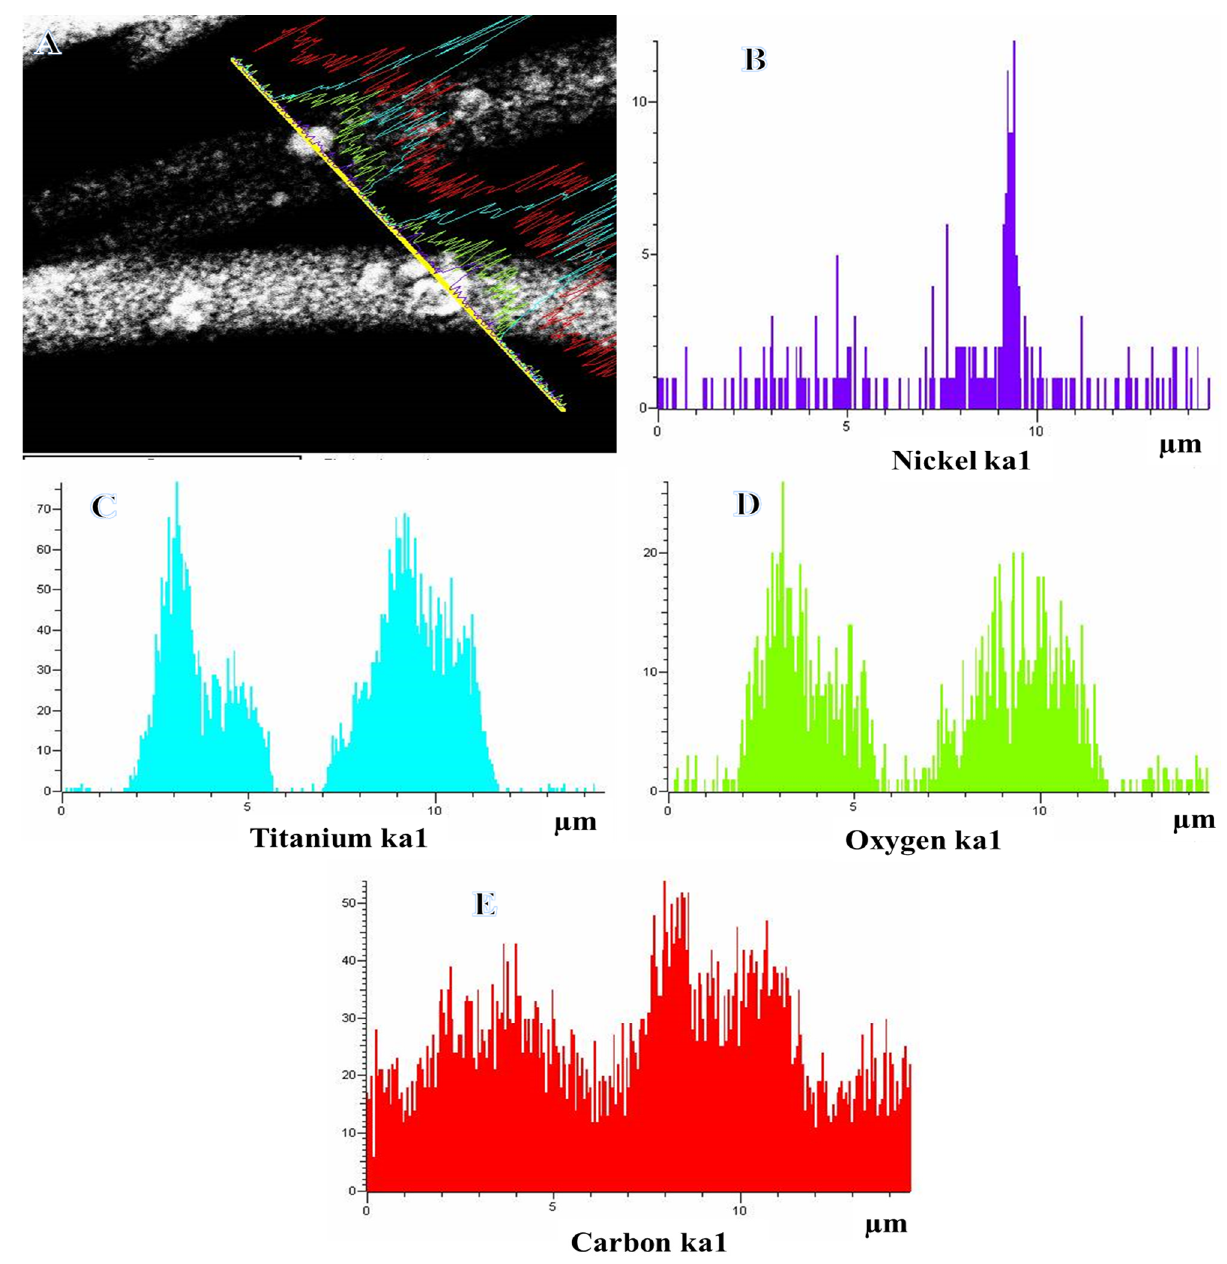
Figure 3. TEM image for a single calcined nanofiber along with the line TEM EDX analysis ( A ) and the corresponding Ti, C, O and Ni line analyses TEM EDX ( B – E ).